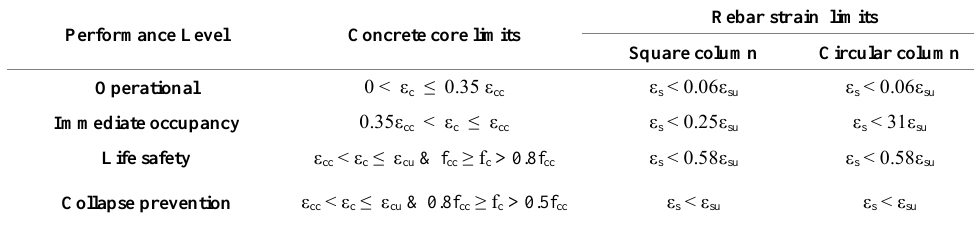
Table 1. Strain values corresponding performance levels [11].